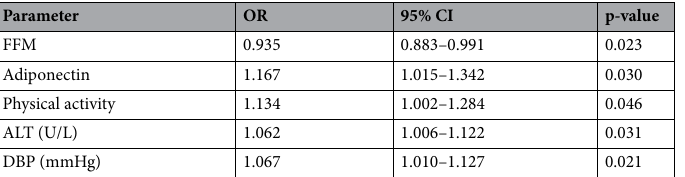
Table 2. Association between demographic, anthropometric and laboratory parameters with hypermetabolism in logistic regression analysis (sample size n = 95). FFM fat free mass, ALT alanine aminotransferase, DBP diastolic blood pressure, OR odds ratio, CI confidence